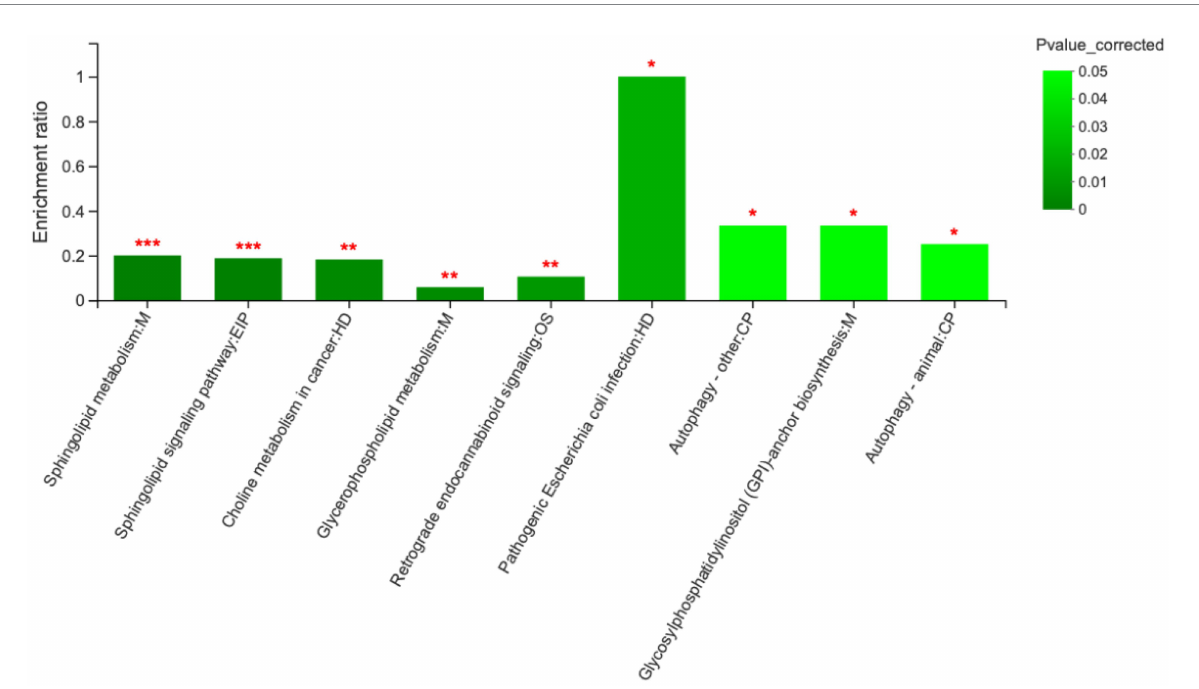
FIGURE 5 Metabolic pathway enrichment analysis between day 1 and day 7. M, EIP, HD, OS and CP are the names of the metabolic pathways in KEGG annotation. M, metabolism; EIP, environmental information processing; HD, human diseases; OS, organismal systems; CP, cellular processes ( n = 6). *** p < 0.001, ** p < 0.01, and * p <